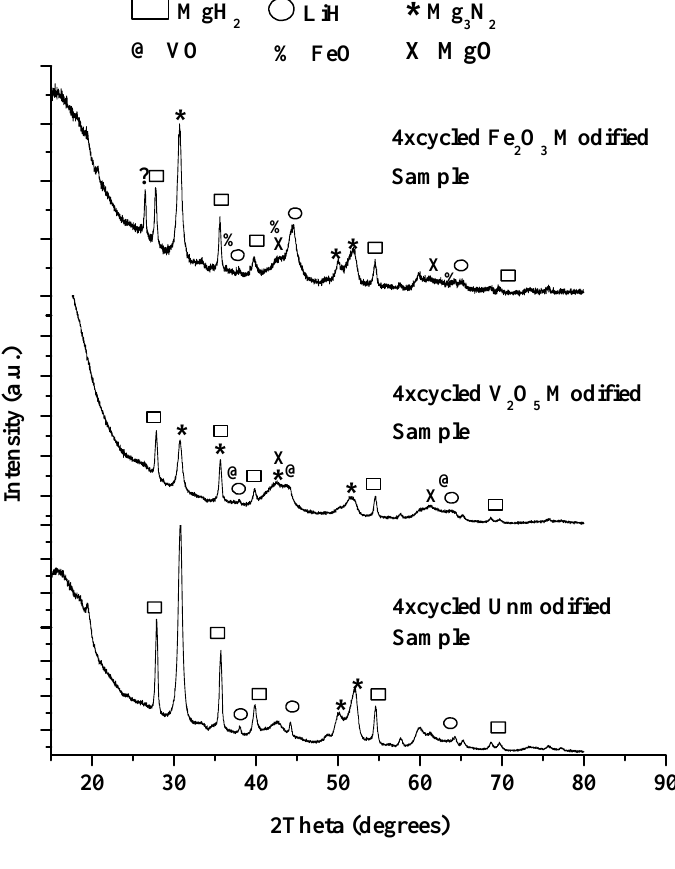
Figure 13. XRD pattern of unmodified (bottom), V 1:1 LiNH :MgH after the 4th rehydrogenation 2 2